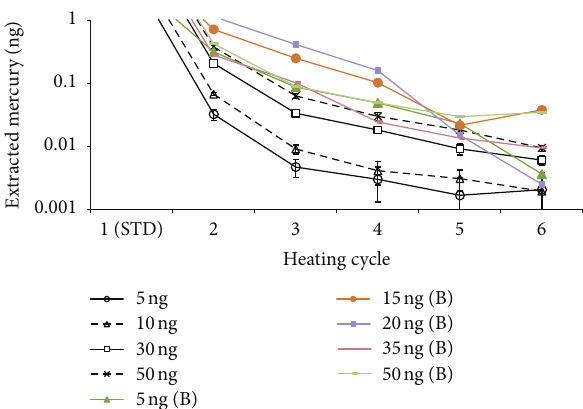
Figure 2: Results of short-term Exp. (Exp. 1). Analytical inten- sity obtained for each heating cycle during the initial analysis of adsorption tubes dosed with different masses of mercury (5, 10, 30, and 50 ng). In each heating cycle, standard mercury was analyzed first and blank runs were made successively. Each point is average of triplicate analysis. In the legend section, the letter “B” is representing investigation of Brown et al. [14]. 5 to 50 ng (B) represents observation from 2nd heating cycle in our previous investigation [14].